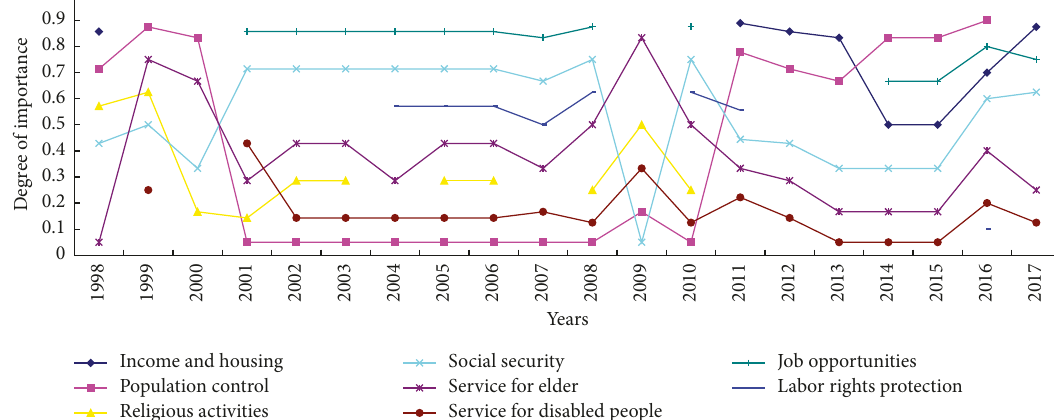
Figure 5: Evolution process of governance attention in J